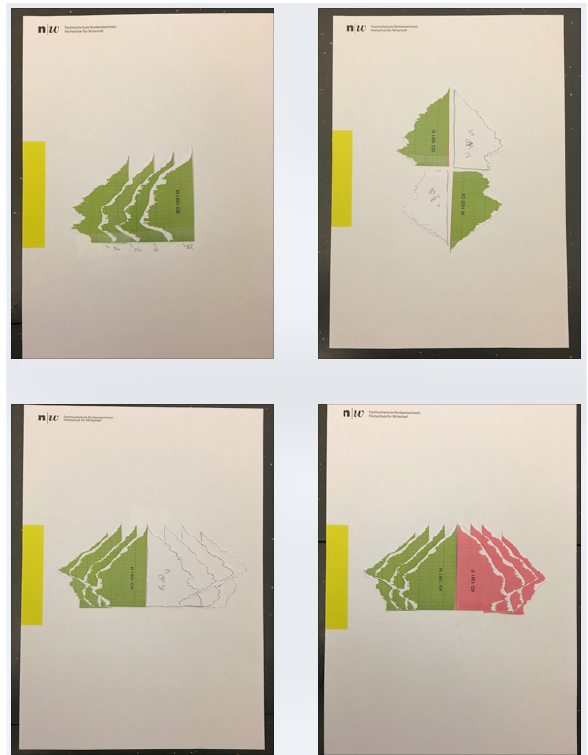
Figure 4: Set of experimental pyramid visualization examples.